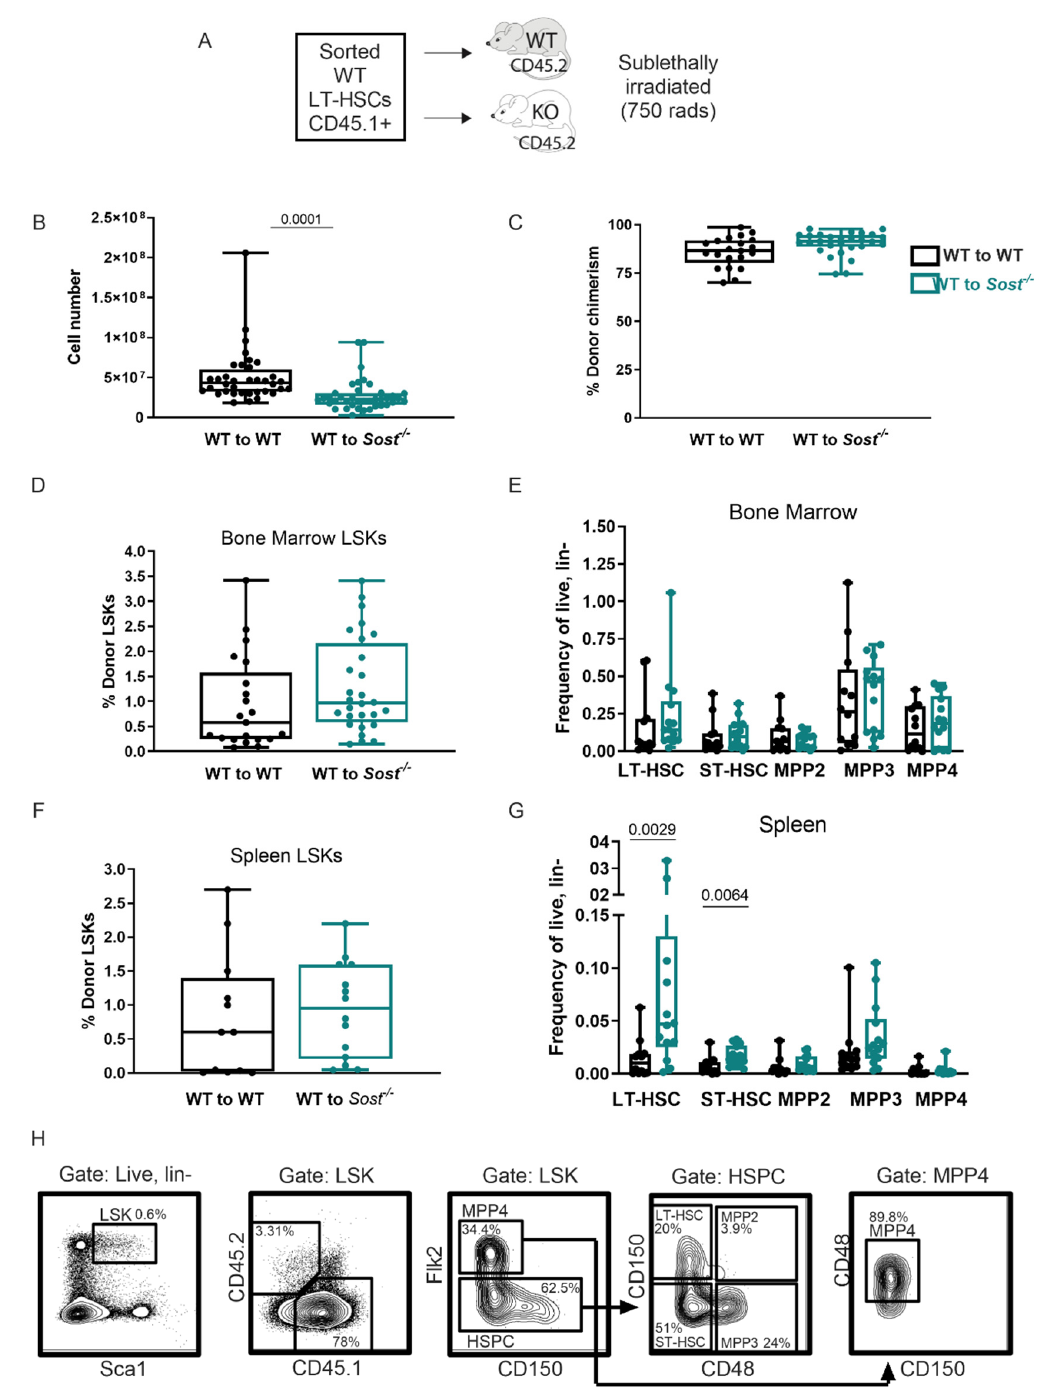
Figure 2. Lack of sclerostin in the bone does not alter hematopoietic progenitor distribution in the bone marrow. ( A ) Experimental scheme of LT-HSC transplant model to study hematopoiesis long-term in Sost -deficient BM microenvironments; ( B ) total bone marrow cellularity in WT → WT (control) and WT → Sost − / − chimeras; ( C ) percent donor chimerism; ( D ) frequency of donor-derived BM LSKs; ( E ) frequency of donor-derived BM HSPCs; ( F ) frequency of donor-derived splenic LSKs; ( G ) frequency of donor-derived spleen HSPCs; ( H ) representative FACS plots depicting gating strategy for HSPC gating in chimeras. Ages of the BM donor mice ranged from 9–17 weeks. Ages of the recipients ranged from 16–22 weeks, when the phenotype of the Sost − / − BM is already established. Both male and female donors and hosts were used. Donor LT-HSC cell numbers ranged from 235–400 cells per mouse. Sort purities ranged from 90.3–100%. Analysis of BM and spleens was performed 19–29 weeks post-transplantation. Data shown are compiled from 4 independent experiments. The actual p -values are shown, underlined.